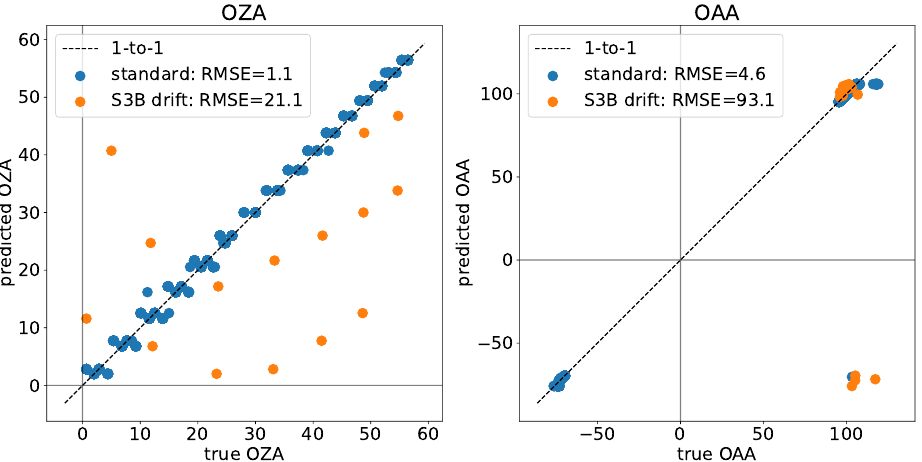
Figure 6. Performanceof the estimation of observation zenith (OZA) and azimuth (OAA) angles for GEE OLCI product. Blue dots correspond to the nominal orbits, and orange dots correspond to the orbits taken by Sentinel-3B spacecraft during the drift phase (from 26 October 2018 to 18 November